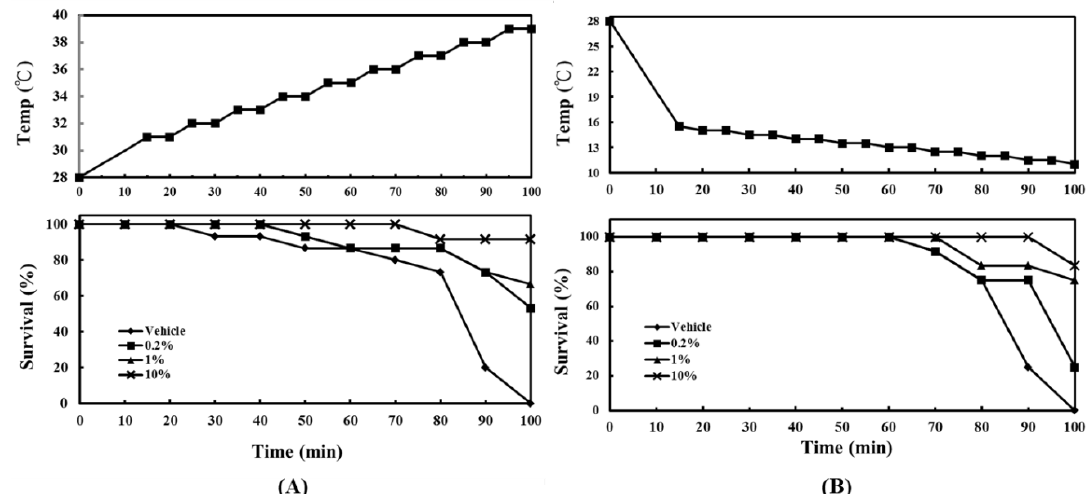
Figure 3. Effect of ACEW supplementation on survival rate of zebrafish under rapid temperature changes. Each group of 12 adult zebrafish was fed with a specified diet for 30 days before the experiment, and then underwent the rapid temperature changes as: ( A ) the heating challenge experiment; ( B ) the cooling challenge experiment. The time course of temperature change is described in Section 4.6.